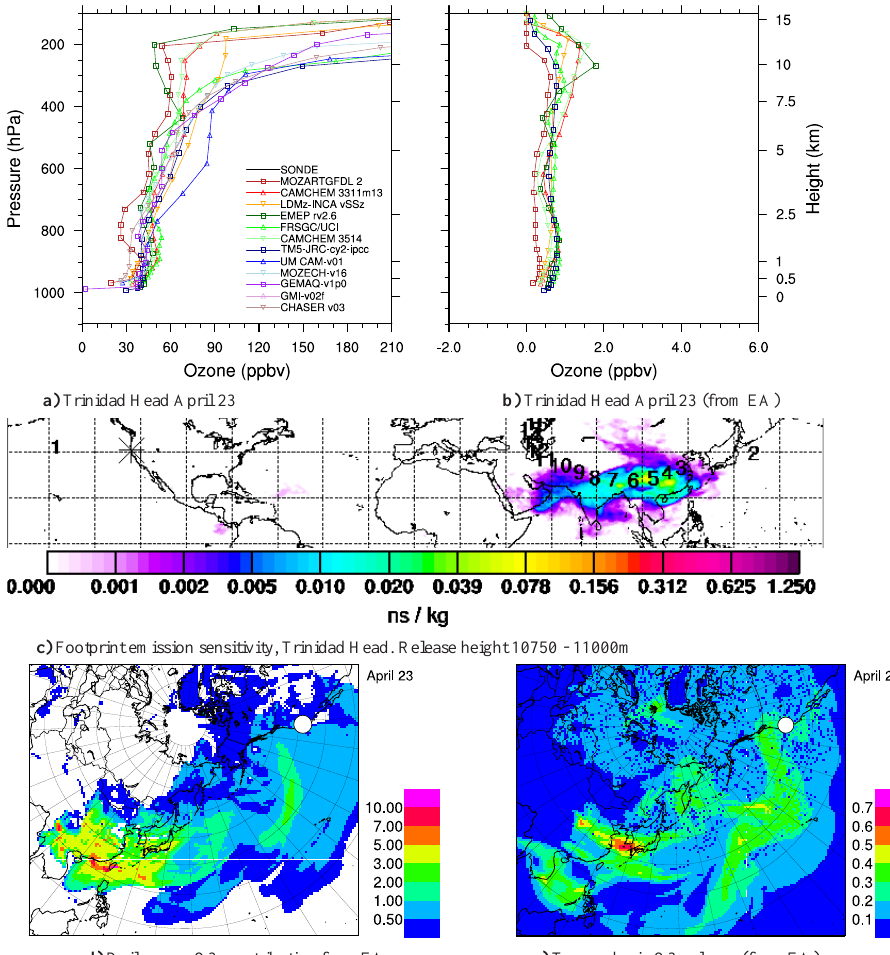
Fig. 14: All panels for April 23, 12 UTC. a) Ozone sounding and calculated vertical profiles in ppb for the 12 models listed in Table 1. b) Calculated difference SRref - SR20%EA in ppb for the 7 models, showing the effect of a 20% reduction of East Asian emissions. c) Footprint emission sensitivity (release height 0 - 250m) from Trinidad Head in ns/kg (nanoseconds/kg). The asterisk marks the position of the ozonesonde site. d) Difference (SRref - SR20%EA) in daily maximum surface-ozone in ppb calculated with the EMEP model. e) Difference (SRref - SR20%EA) in tropospheric ozone column (DU) calculated with the EMEP model. White circle marks the position of Trinidad Head in d) and e).